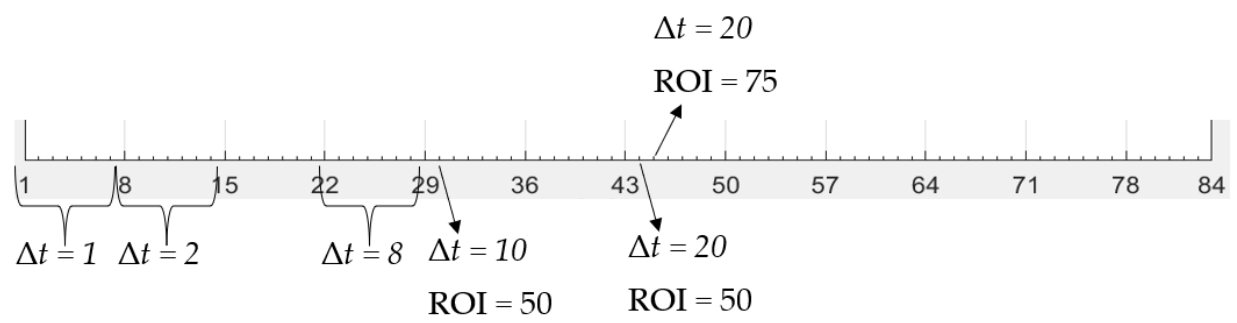
Figure 7. Visual guide to aid in the interpretation of the x -axis of the analysis plots with multiple networks. Starting with the larger ticks, with the showing indexes, these mark the start of a new ∆ t value. As for the smaller ticks those correspond to the different ROI radii used within each group of ∆ t groupings.